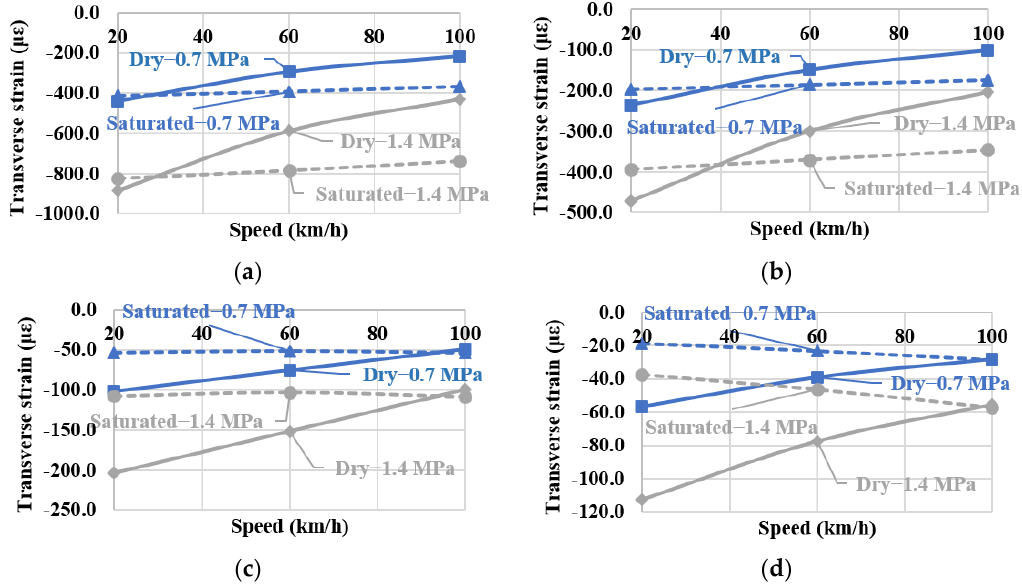
Figure 11. Variation trends of transverse strain in dry and saturated asphalt pavement: ( a ) Surface layer (h = 0 m); ( b ) Upper layer bottom (h = 0.05 m); ( c ) Middle layer bottom (h = 0.11 m); ( d ) Lower layer bottom (h = 0.18 m).